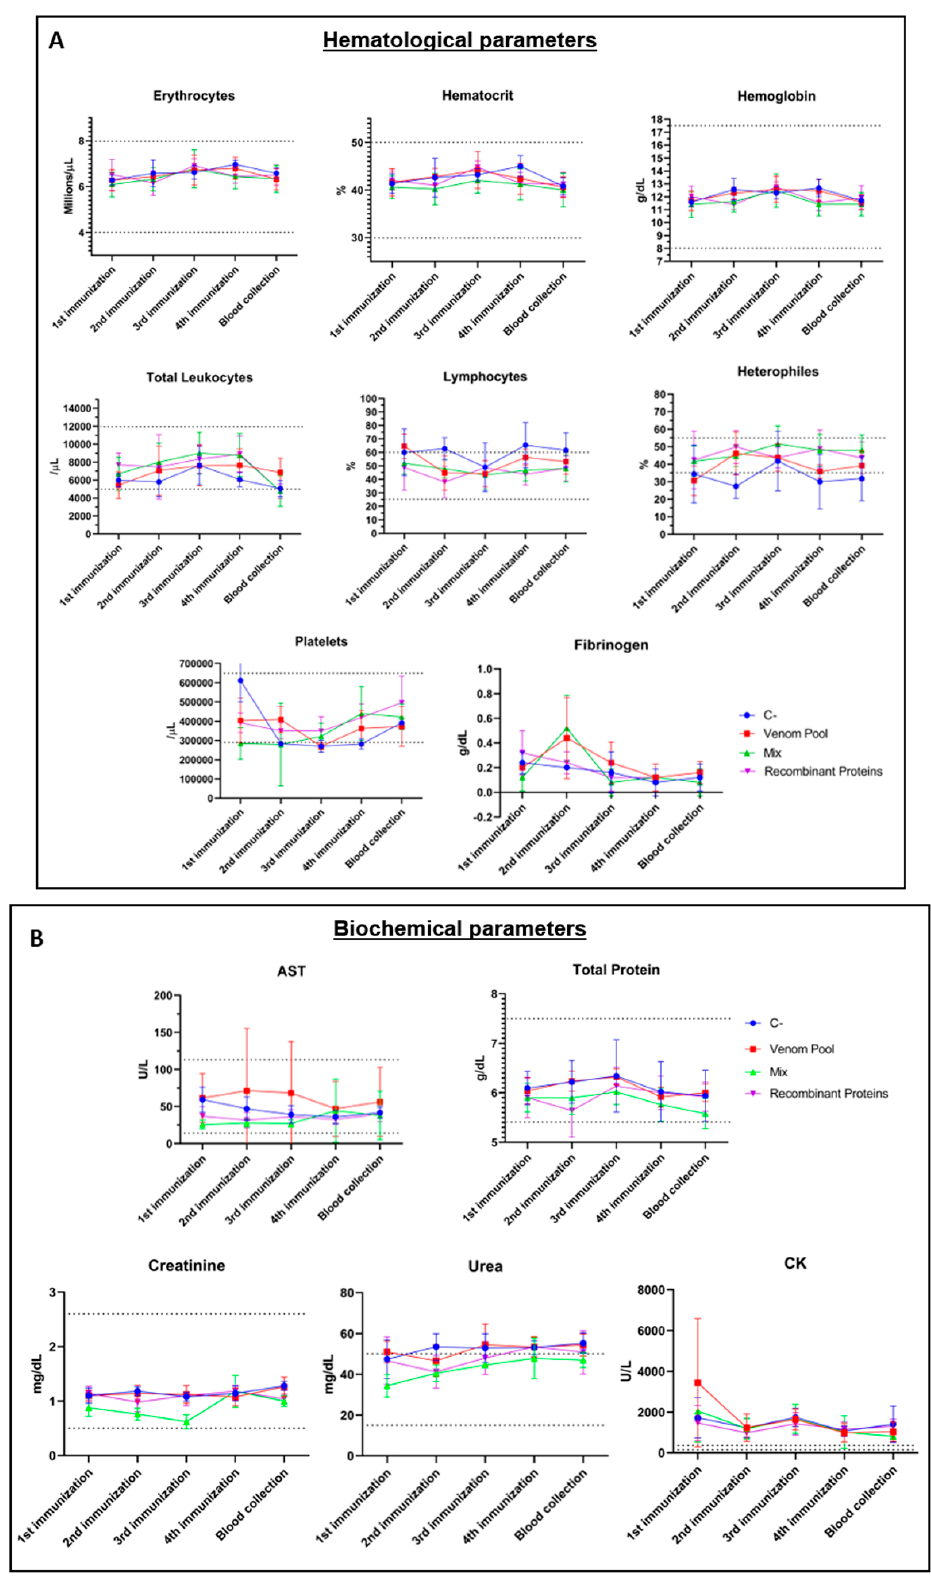
Figure 3. Monitoring of blood parameters of immunized rabbits. Hematological ( A ) and biochemical ( B ) parameters were verified from blood samples collected immediately before each immunization step.